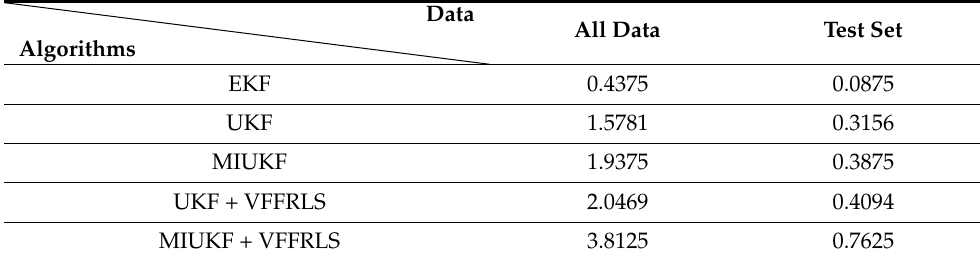
Table 7. Time consumption of Kalman filter frame algorithm (s).